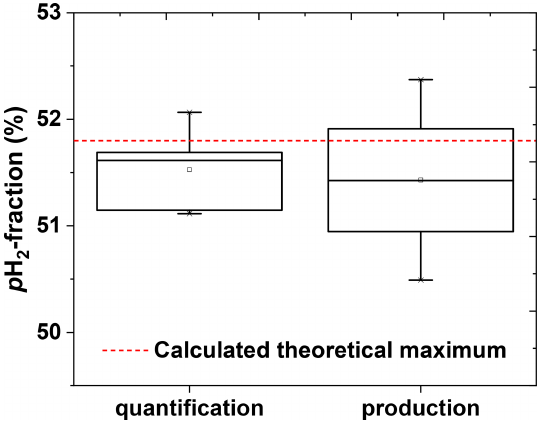
Figure 8. Reproducibility of the p H 2 quantification method (left) and p H 2 production cycle (right). The left boxplot shows the pre- cision of the quantification method. The p H 2 quantification proto- col was repeated five times with the same p H 2 batch. The obtained p H 2 fraction was (51 . 5 ± 0 . 4)% that gives us an impression of quan- tification precision. The right boxplot shows the reproducibility of the production. The production of p H 2 and quantification protocols were repeated once on 4 different days. The obtained p H 2 frac- tion here was (51 . 6 ± 0 . 9)%; the error value includes production and quantification errors. PHG parameters of p H 2 preparation: 20- bar inlet pressure, 10-bar final pressure in the storage cylinder and f r = 0 . 9SLM. All errors are given by the standard deviation.